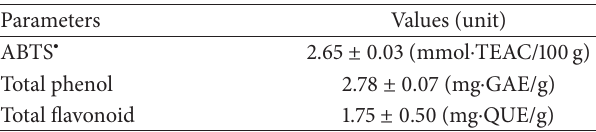
Table 2: ABTS ∙ scavenging ability, total phenol content, and total flavonoid content of kola nut ( Cola acuminata) seeds aqueous